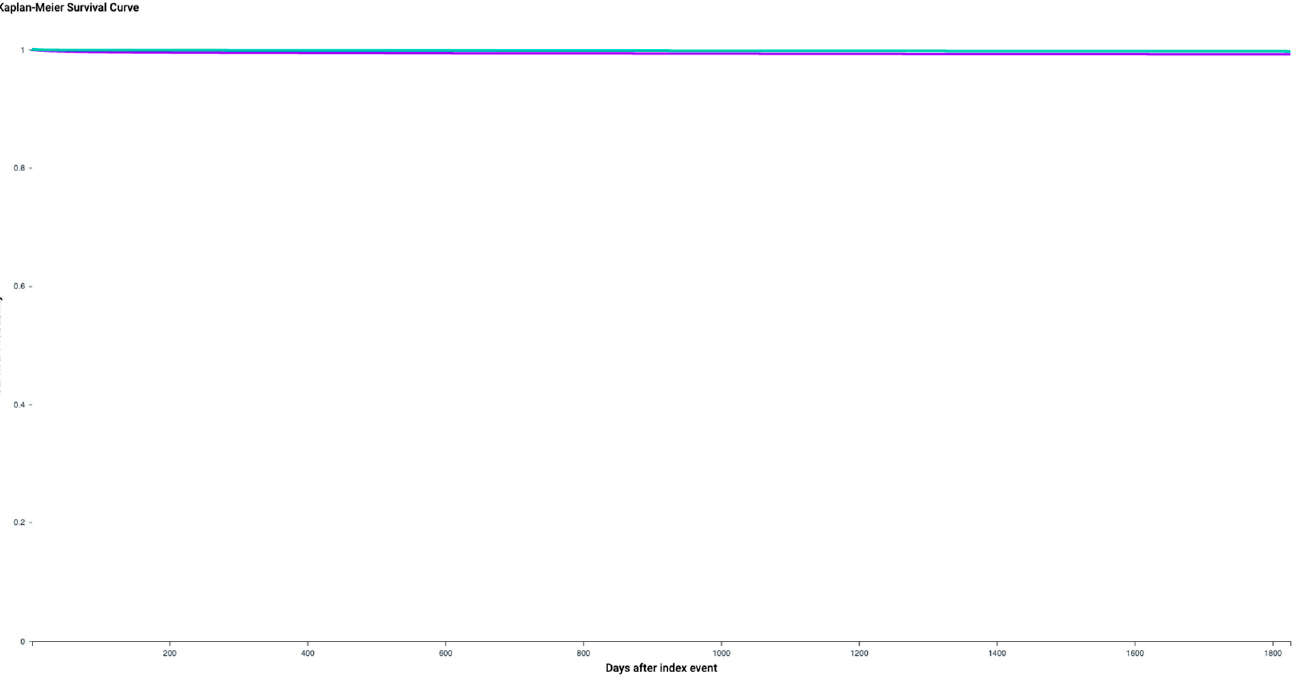
Figure 3. Kaplan–Meier diagram of the cohorts I (patients with recurrent aphthous stomatitis (RAS; ICD-10 code K12) and II (subjects without RAS). cohort I = purple; cohort II =